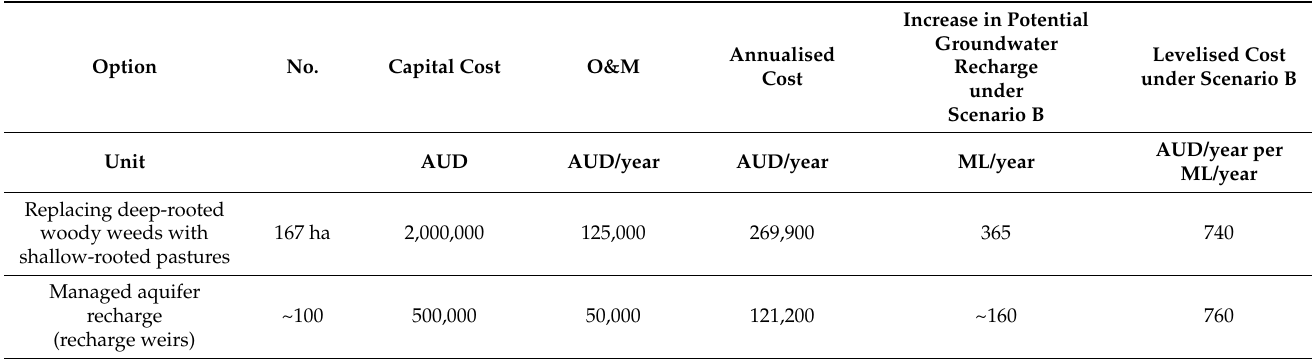
Table 7. Diffuse management intervention options. Annualised and levelised cost based on assumed service life of infrastructure and 7% discount rate. Cost estimates include contingency and have an estimated uncertainty of − 30% to +50%.